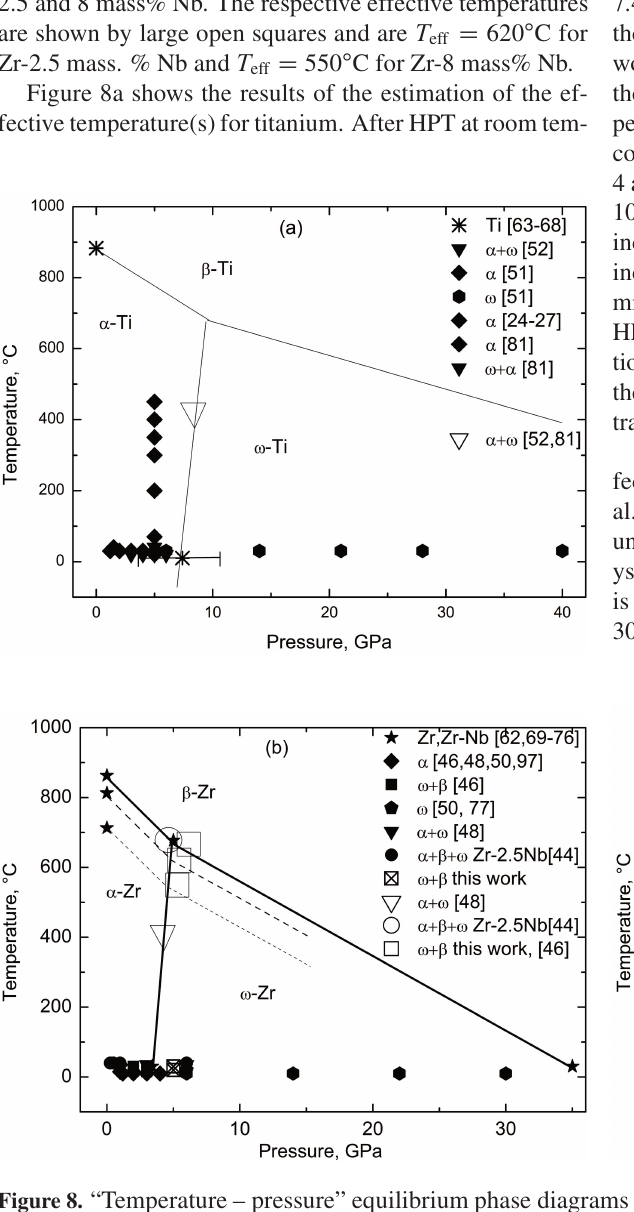
Figure 8. “Temperature – pressure” equilibrium phase diagrams with data for HPT-experiments for (a) titanium (crosses, thin lines), (b) zirconium and (c) hafnium. Small full symbols mark the conditions of HPT-treatment and demonstrate the phases present in the samples after HPT. Large open symbols mark the effective temperatures in the respective phase fields. Diamonds are for the pure ˛ -phase. Circles are for the ˛ C ! C ˇ mixture. Triangles are for the ˛ C ! mixture. Squares are for the ! C ˇ mixture. Hexagones are for the pure !